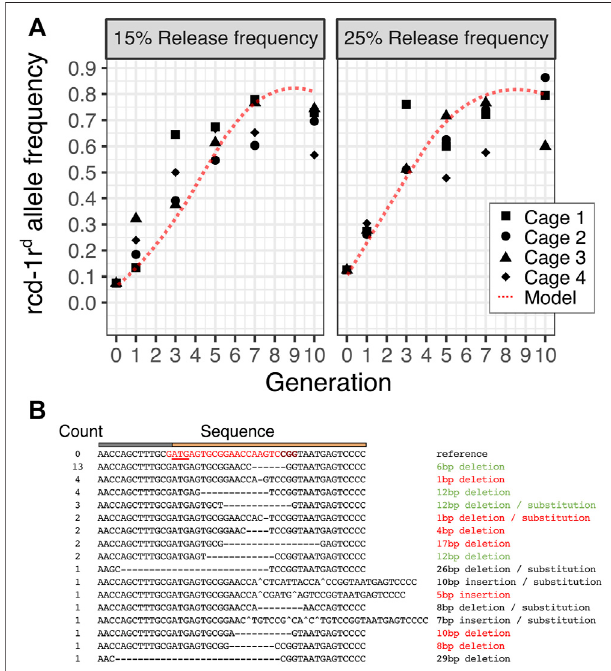
FIGURE 3 | Population dynamics of the rcd-1r d gene drive. (A) The predicted allele frequency of rcd-1r d in four replicate cages maintained for 10 generations and sampled at generations 1,3,5,7, and 10 at two initial release frequencies (15% or 25% hemizygote rcd-1r d corresponds to a starting allele frequency of 7.5% or 12.5%, respectively) is shown. The dotted red line represents the predicted frequency according to the mean of 25 runs of a stochastic model of the rcd-1r d drive. A minimum of 31 and a mean of 42 individuals were genotyped per condition, cage, and generation. (B) . Summary of target site variants identi fi ed by Sanger sequencing in generation 10 using hemizygous individuals from all eight cage populations. The putative impact of the mutation as disruptive (red), possibly tolerable (green), and ambiguous/unclear (black) is